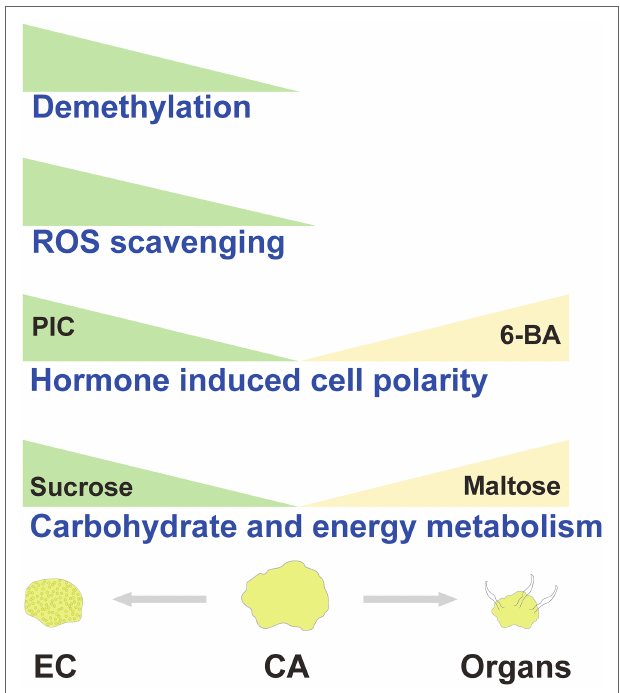
FIGURE 8 | Hypothesized model diagram of callus differentiation direction in A. praecox